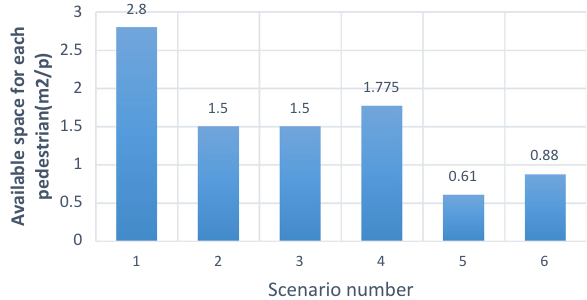
Fig. 6 Pedestrian space in platform under different scenarios